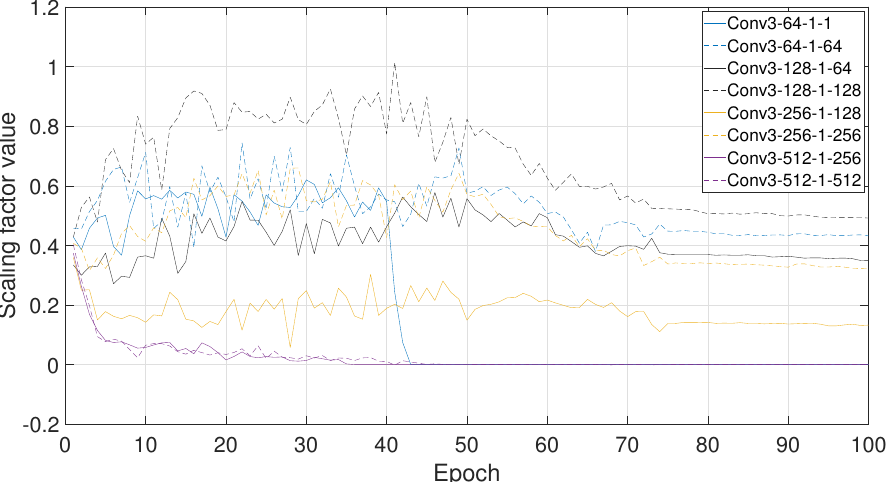
Figure 10. The scaling factor of different channels under different convolutional layers changes dynamically with the increase of the epoch of training rounds. The deeper layer is, the faster the channel’s scaling factor of this layer will to be near